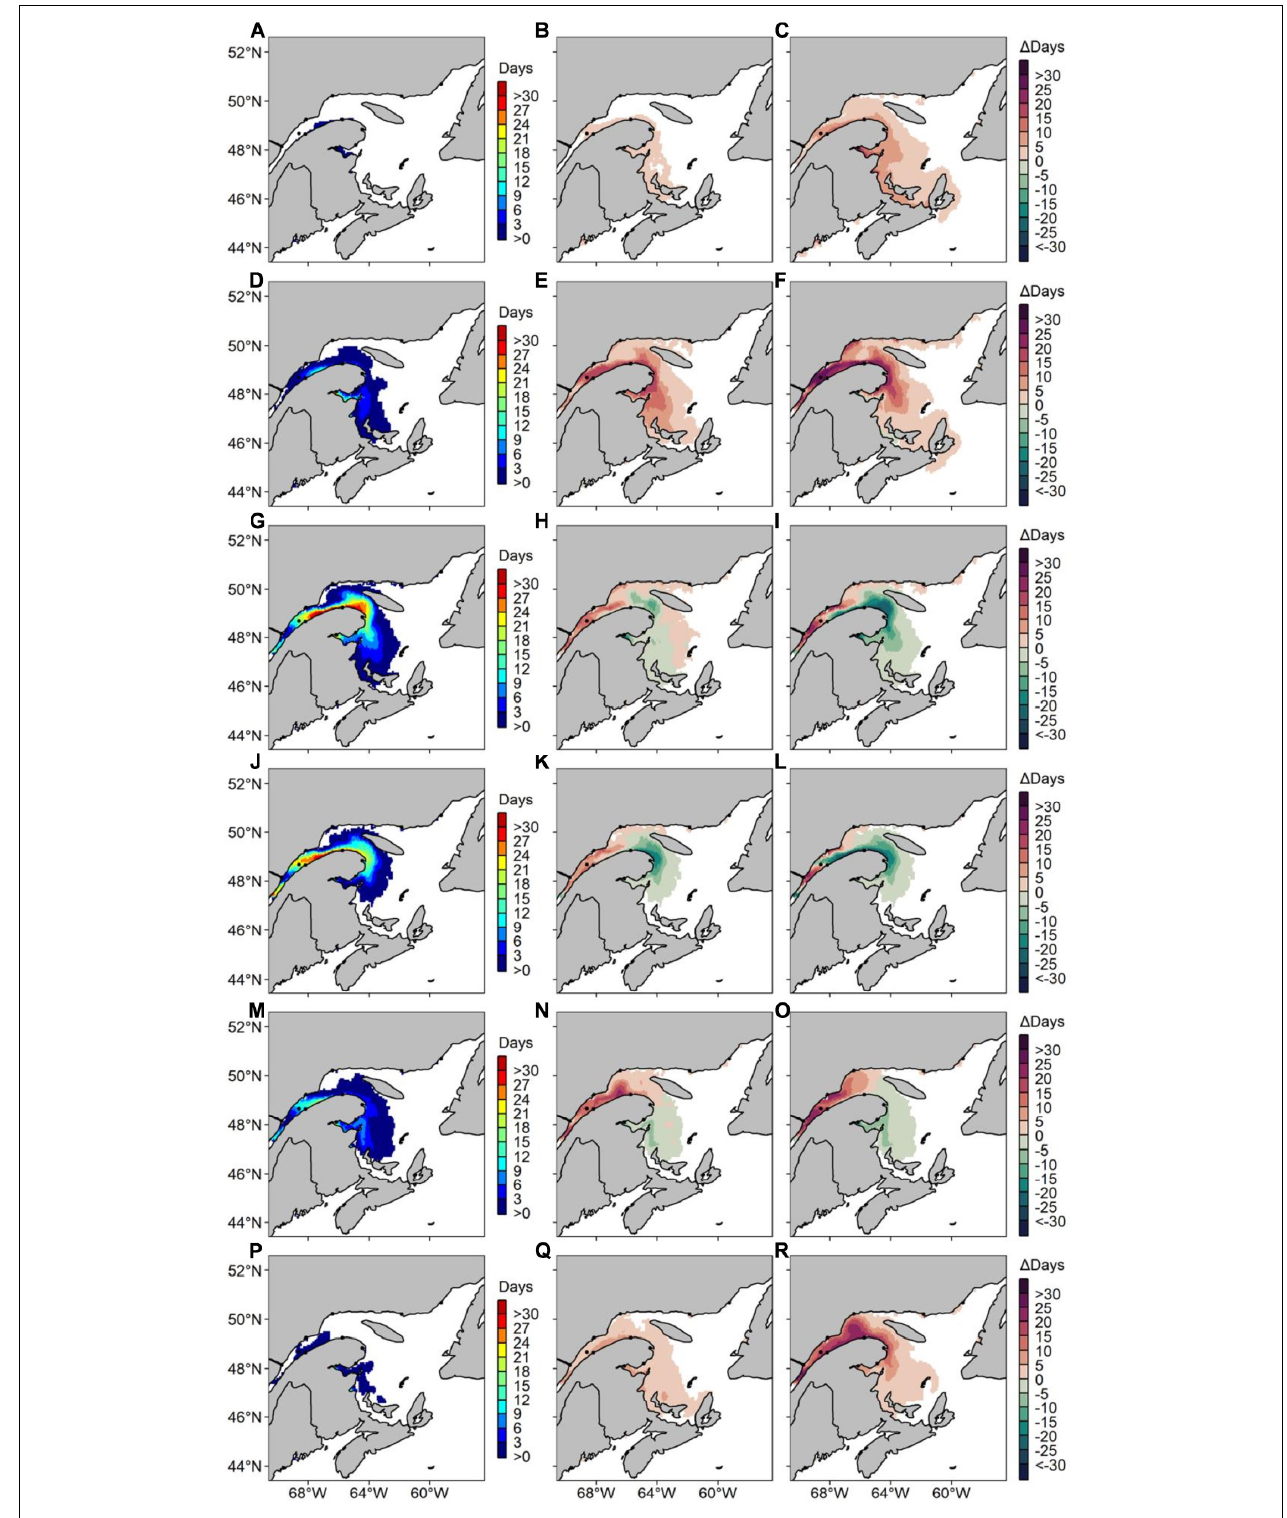
FIGURE 10 | Average number of risk days with Alexandrium catenella ≥ 1000 cells L − 1 along Canada’s East coast under CanESM2 RCP 8.5 for (A) May 1999–2008, (B) difference in average number of risk days between May 1999–2008 and May 2050–2059 and (C) difference in average number of risk days between May 1999–2008 and May 2090–2099. Same pattern applies for (D–F) June, (G–I) July, (J–L) August, (M–O) September, and (P–R) October.